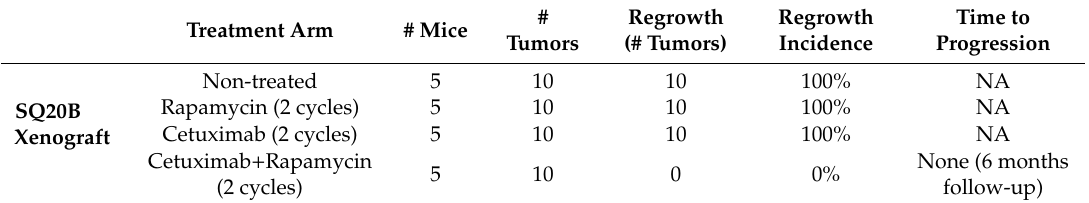
Table 1. Cetuximab and rapamycin co-treatment prevents tumor relapse in nude mice bearing SQ20B xenografts. Nude mice bearing SQ20B and treated with 2 cycles of rapamycin or